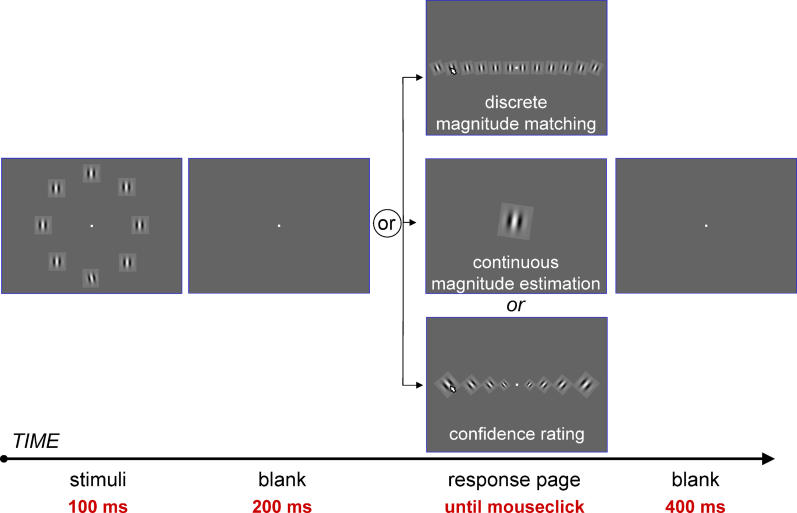
Illustration of the Experimental SequenceThe leftmost panel shows a typical stimulus set (in this case a counterclockwise tilted target with seven vertical distractors) displayed for 100 ms. A blank page followed for 200 ms. Then, the response page was shown until the subject responded. In the discrete magnitude-matching task (top) we used icons representing the stimulus set (i.e., all possible orientations for the target: ± 0.5°, 1°, 2°, 4°, 8°, and 16°). Observers clicked the icon that best matched their impressions for that trial. In the continuous magnitude estimation task, a response probe resembling the target (but two times larger) appeared and could be rotated through ± 32° by lateral motion of the mouse. In the confidence rating task the icons were all ± 45° off vertical, and varied in size (from 0.5 to two times the actual stimulus size), where size represented observer confidence. After the mouse click a blank page appeared for 400 ms before the next trial. Responses were classified as correct or incorrect (depending on the chosen sign of tilt), and stored together with its magnitude match or the confidence rating.